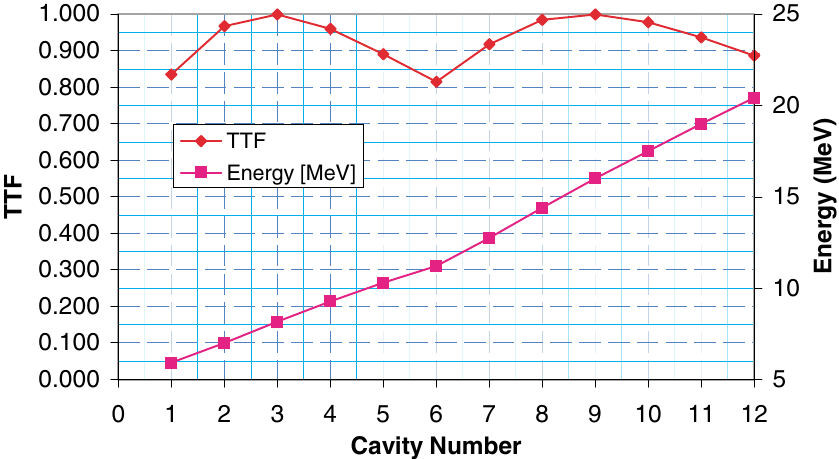
FIG. 1. (Color) Synchronous particle energy and transit time factor along the linac; the TTF is calculated for four ideal gaps, with (cid:1) 0 : 12 and 0.17. optimum (cid:3) 0